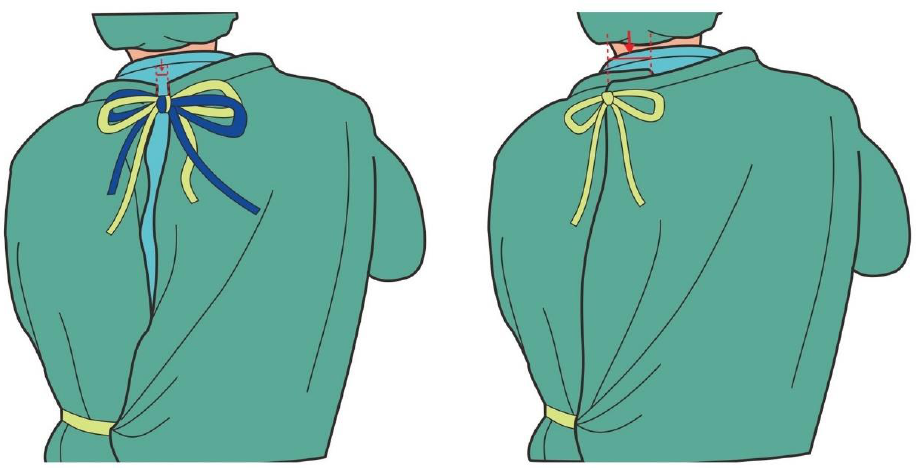
Figure 3. Fastening the ties with a tightening force reaching 1 kg. Nurs. Rep. 2020 , 10 , x